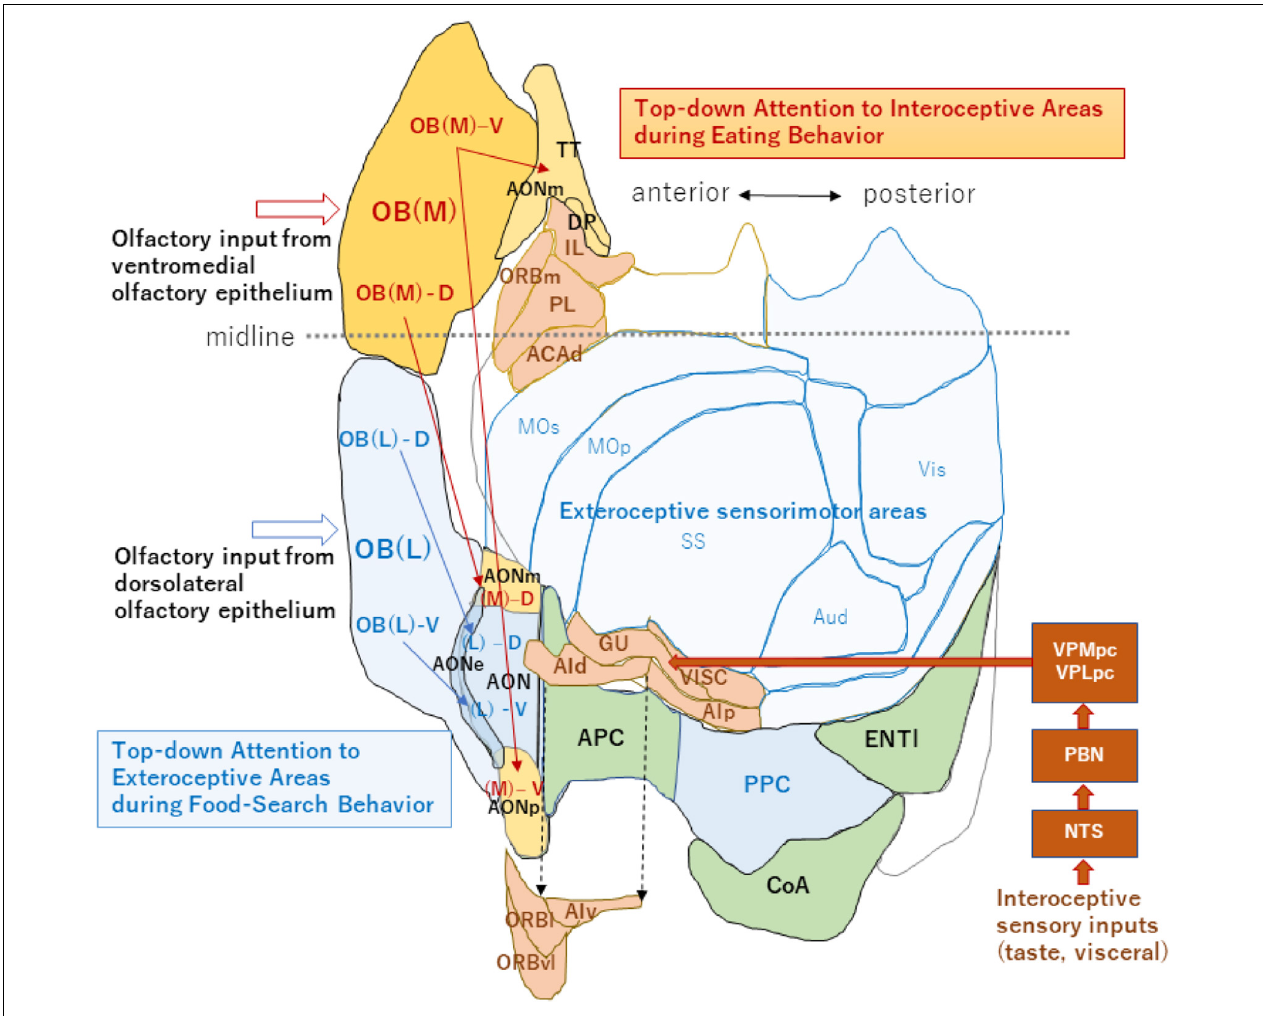
FIGURE 2 | An unfolded map of the neocortex and olfactory cortex (left hemisphere). A dorso-centered view is schematically shown for the exteroceptive and interoceptive sensorimotor regions. Neocortex areas are classified into the exteroceptive sensorimotor (blue) and interoceptive sensorimotor (peach) regions. The exteroceptive region includes the somatosensory (SS), primary motor (MOp), secondary motor (MOs), auditory (Aud), and visual (Vis) areas. The interoceptive region includes the gustatory (GU), visceral (VISC), agranular insular (dorsal part, AId; ventral part, AIv; and posterior part, AIp), orbital (lateral part, ORBl; ventrolateral part, ORBvl, and medial part, ORBm), infralimbic (IL), prelimbic (PL), and dorsal part of the anterior cingulate (ACAd) areas. Interoceptive sensory inputs, including taste and visceral signals reach the interoceptive sensory cortex (including GU and VISC) via the nucleus of solitary tract (NTS), parabrachial nucleus (PBN) and parvocellular parts of the ventral posteromedial thalamic nucleus (VPMpc), and ventral posterolateral thalamic nucleus (VPLpc). AIv, ORBl, and ORBvl are displaced as indicated by the arrows of broken lines to avoid overlap with the olfactory cortex. The medial map of the OB (dark orange), their tufted-cell target areas in the AON and TT (pale orange), and neocortex interoceptive areas (peach) receive the top-down attention signal during eating behavior. The lateral map of the OB (blue), their TC target areas in the AON (blue), and PPC/neocortex exteroceptive areas (pale blue) receive the top-down attention signal during food-searching behavior. This unfolded map was generated using the Allen Institute for Brain Science (2004) (https://mouse.brain-map.org/static/atlas). The midline is shown by a broken line (anterior side is left). For additional abbreviations, please see the legend to Figure 1